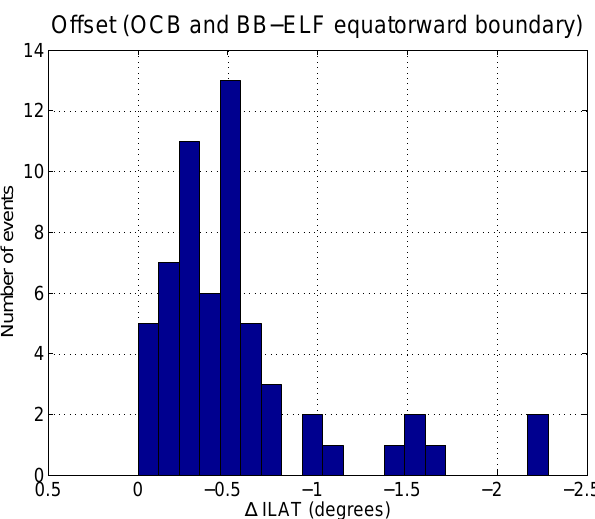
Fig. 6. Histogram of the latitudinal distance between the onset of the cusp ion dispersion and the onset of BB-ELF. A negative value means the BB-ELF start poleward of the onset of ion